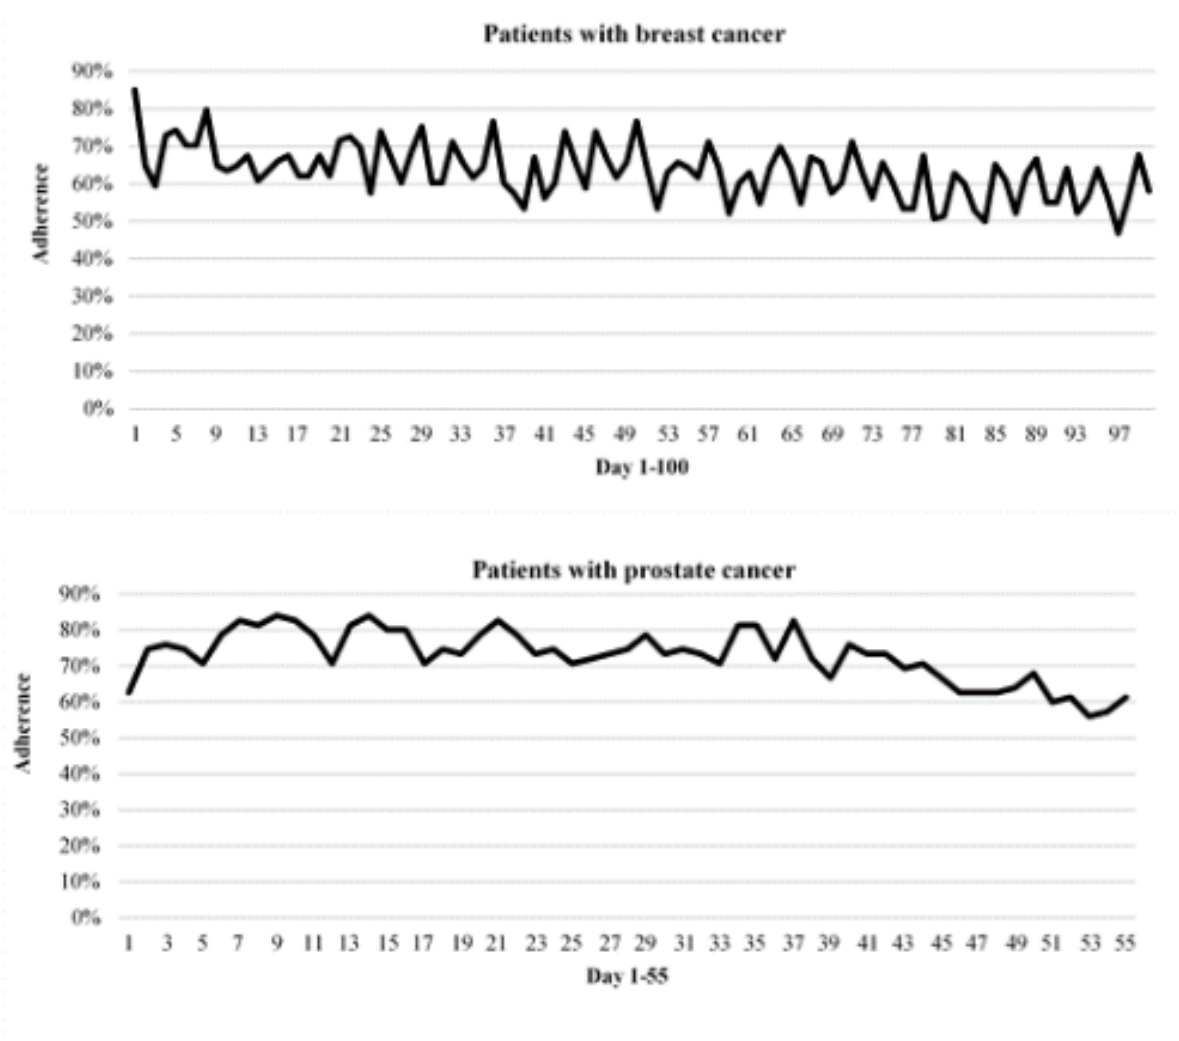
Figure 2. Adherence to symptom reporting over